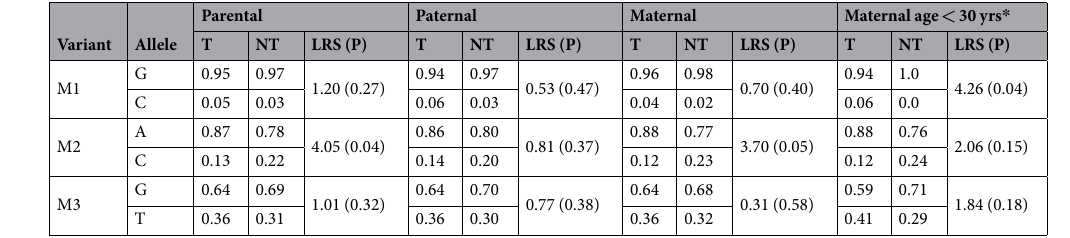
Table 2. Familial allelic transmission analyzed by Haplotype based haplotype relative risk